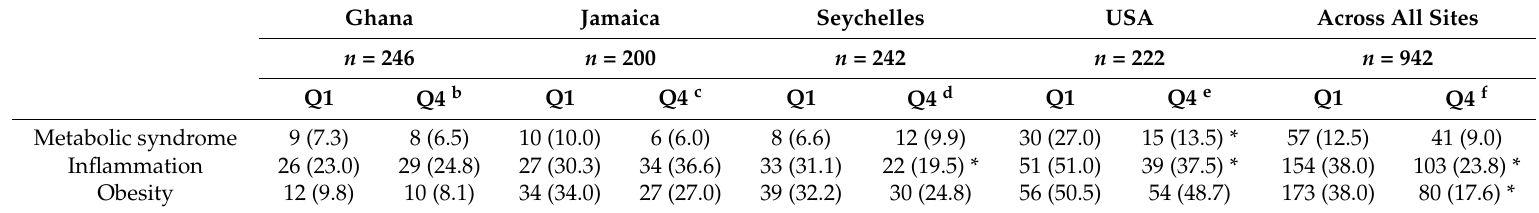
Table 3. Comparison of cardiometabolic risks by fiber quartiles at each site, N (%). Ghana Jamaica USA